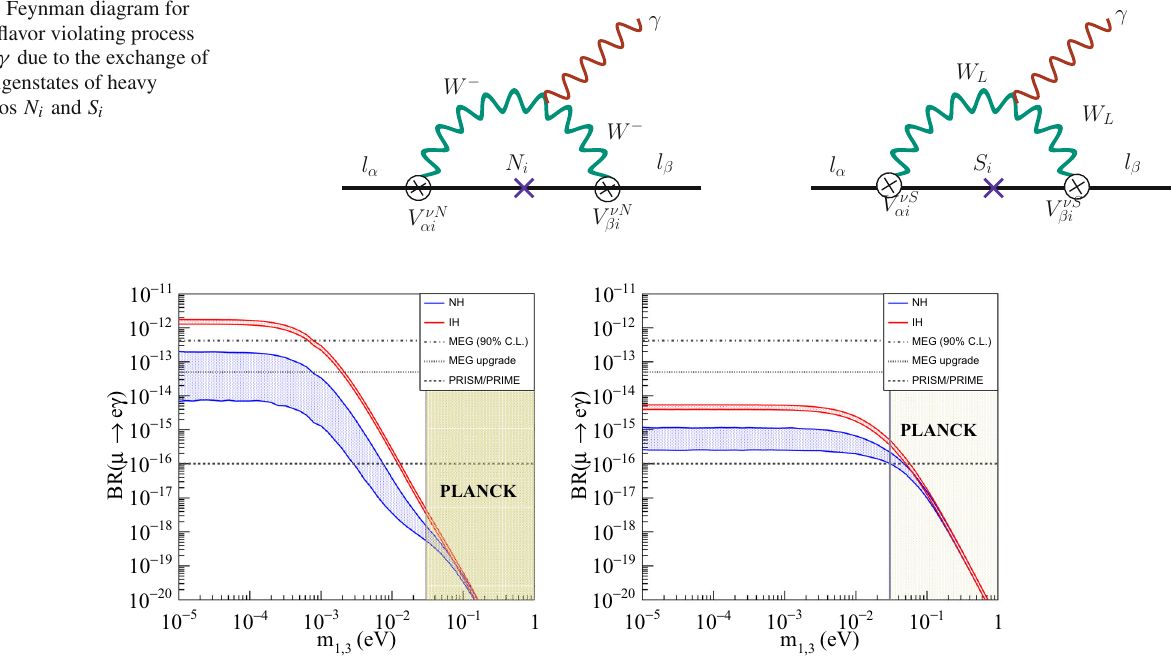
Fig. 2 Branching ratio of the lepton flavor violating process, μ → e γ as a function of lightest neutrino mass m 1 for NH and m 3 for IH. The blue (NH) and red (IH) coloured regions display the allow due to the exchange of heavy right handed neutrino ( N R ) (left-panel) and heavy sterile neutrino ( S L )